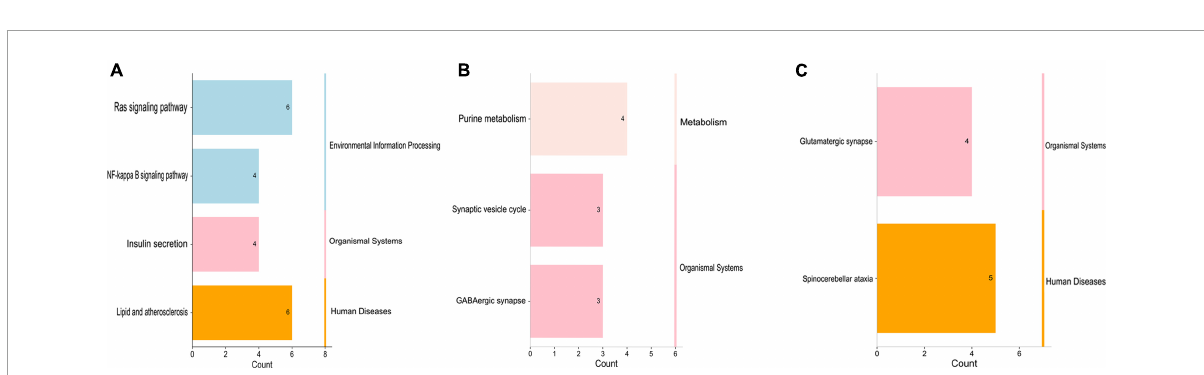
FIGURE4 Kyoto Encyclopedia of Genes and Genomes analysis of three differentially expressed tsRNAs. (A) tRF-59:76-Tyr-GTA-2-M3, (B) tRF-60:76-Val-AAC-1-M5, (C) tRF-1:29-Gly-GCC-1. The target gene of tRF-59:76-Tyr-GTA-2-M3 is involved in regulation of the pathways in purine metabolism (PDE6H, AK2, ADCY1, and AK9), synaptic vesicle (SLC6A11, SLC6A1, and AP2A2), and GABAergic synapse (SLC6A11, ADCY1, and SLC6A1); the target gene of tRF-60:76-Val-AAC-1-M5 is involved in regulation of the pathways in lipid and atherosclerosis (CAMK2B, VAV3, PLCB3, NFATC3, TNFRSF10B, and BCL2L1), Ras signaling pathway (PLA2G2F, ANGPT4, RAB5B, RASAL1, BCL2L1, and VEGFA), NF- κ B signaling pathway (CCL4, CFLAR, ERC1, and BCL2L1), and Insulin secretion (CAMK2B, PLCB3, KCNJ11, and ATP1B2); while the target gene